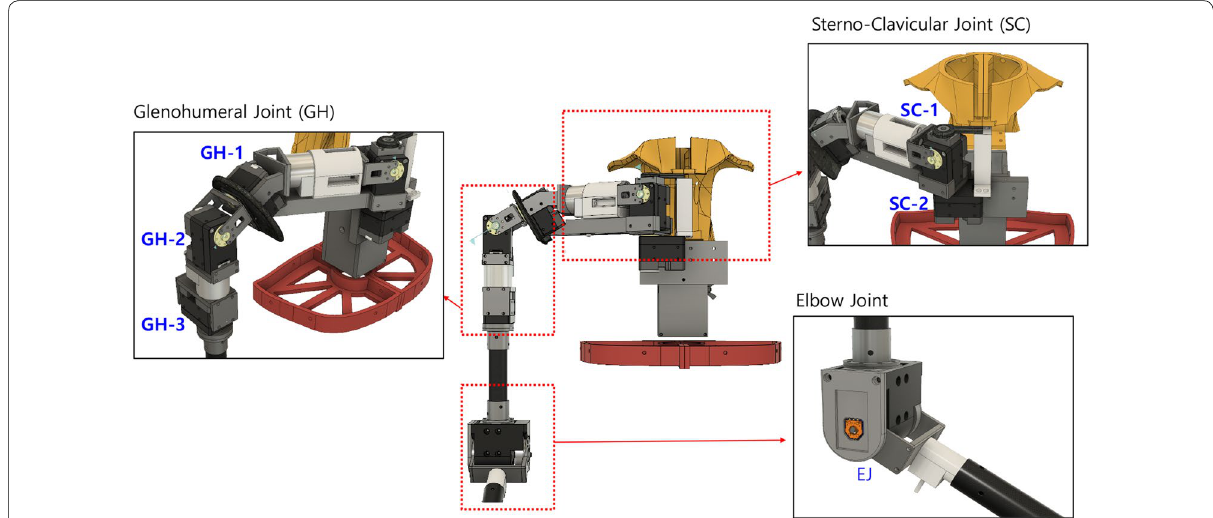
Fig. 1 Configuration of the upper limb of care training assistant